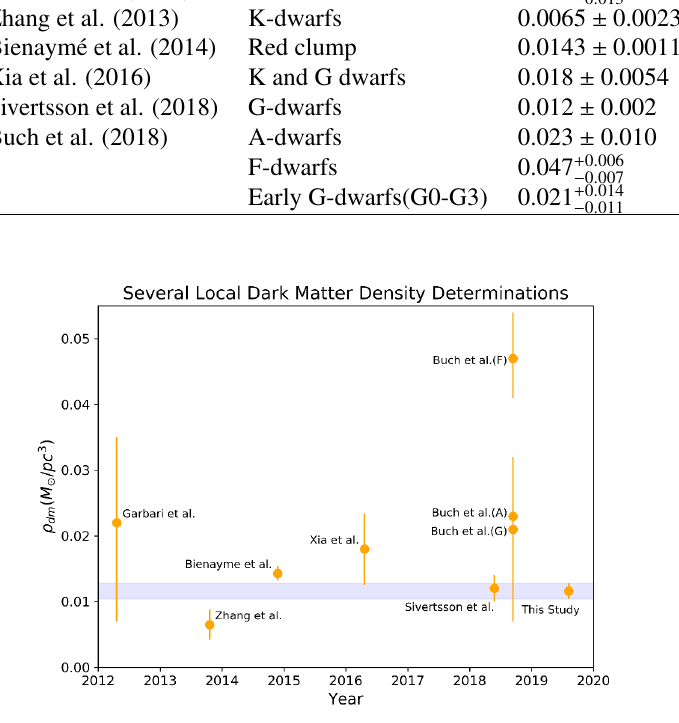
Figure 2. Comparison of our result with other determinations of ρ dm conducted by some researchers. The error bar in our result takes into account only statistical